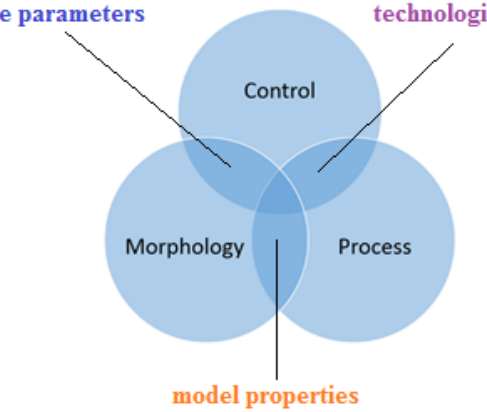
Figure 1. Relationship between surface morphology, control, and process.